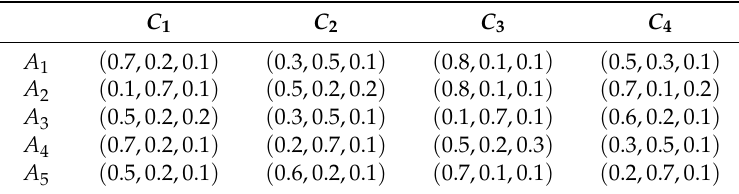
Table 3. Decision matrix A 3 from expert E 3